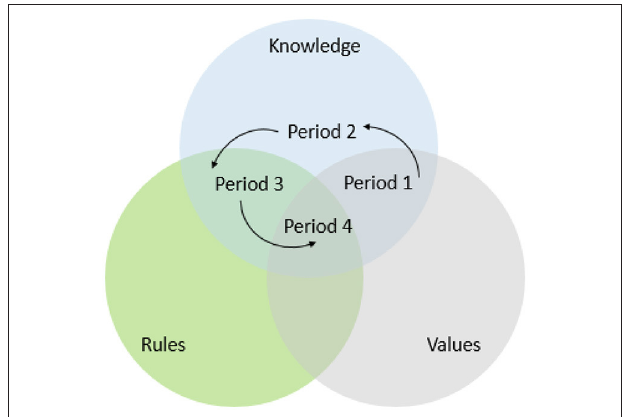
FIGURE 8 | Distribution of the four evolutionary periods within the value-knowledge-rules